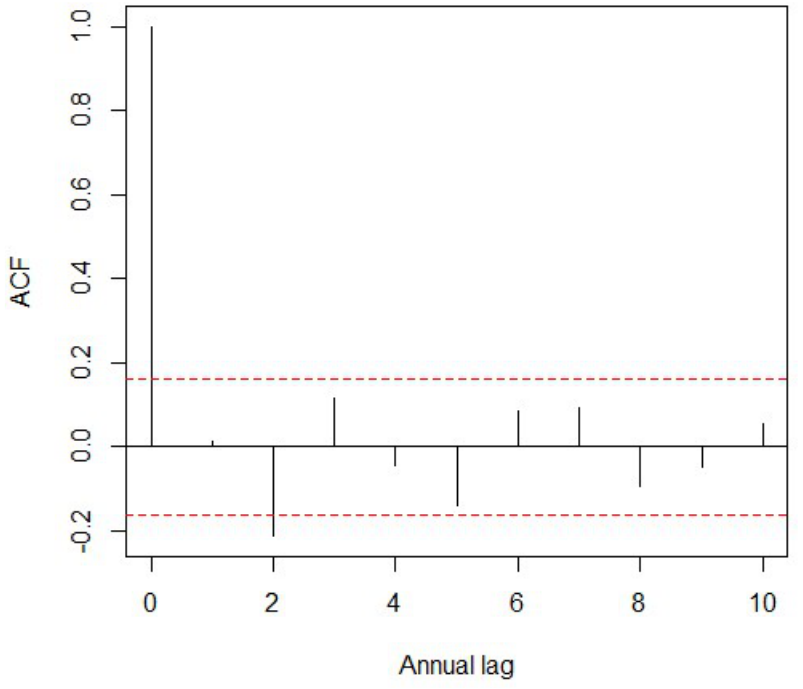
Figure 3. Annual real rates of linear return. Autocorrelation function.